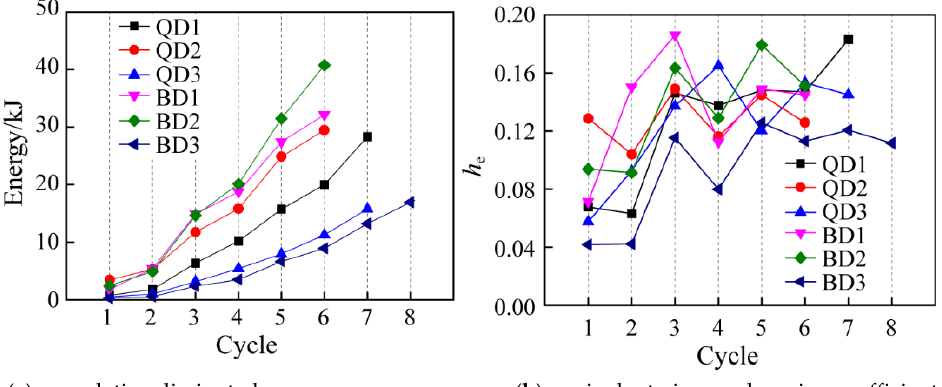
Figure 10. Energy dissipation curves for six specimens. ( a ) cumulative dissipated energy; ( b ) equivalent viscous damping coefficient he energy dissipation capacity of the specimen can also be expressed by an equivalent viscous damping ratio h e , a major index to measure the seismic performance of the specimen. It is calculated by [30]: